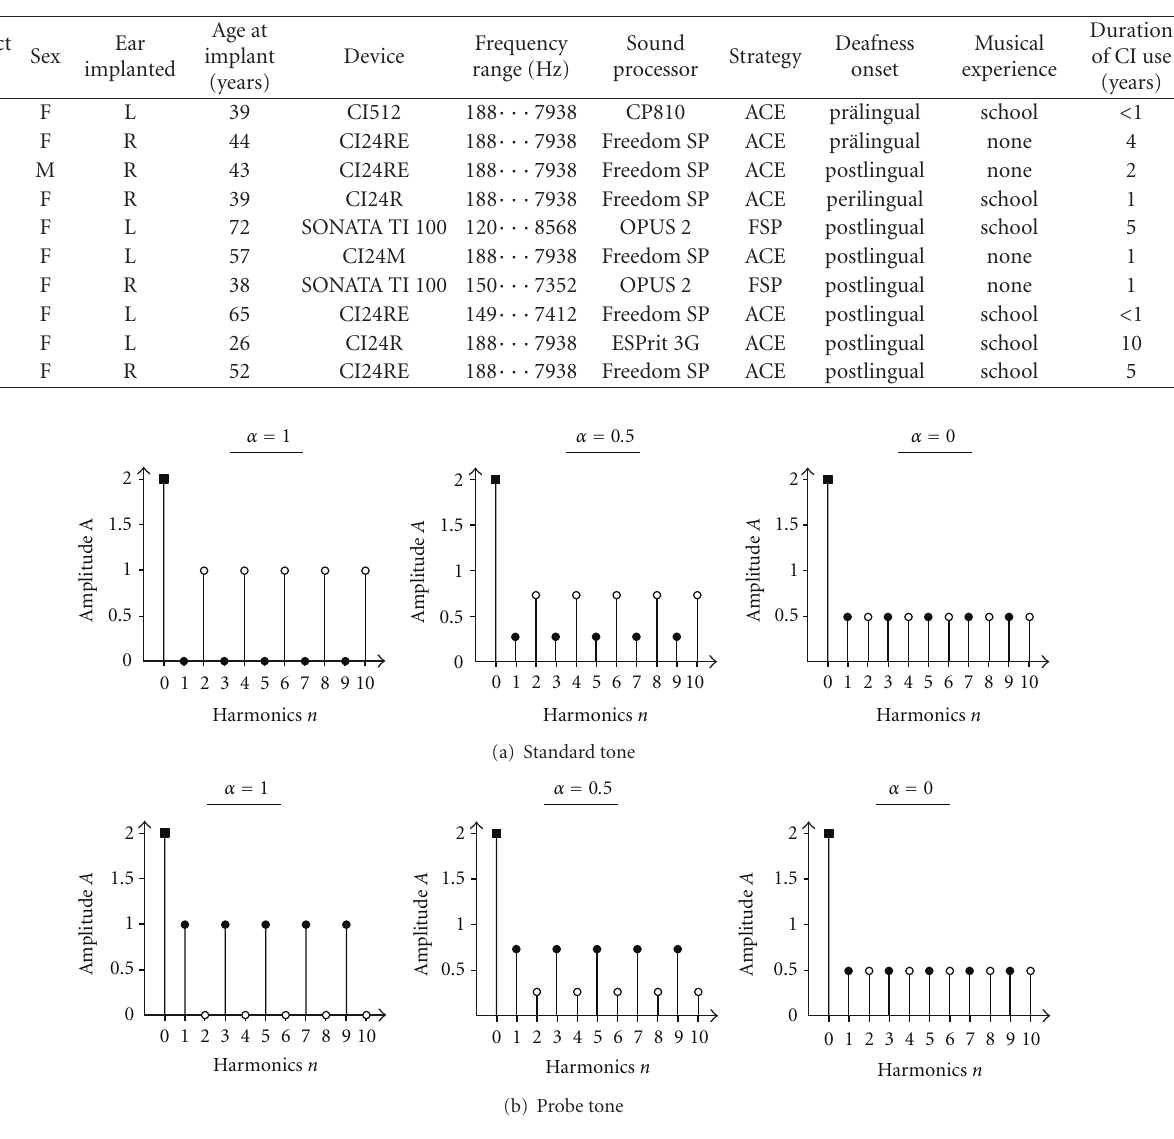
Figure 1: Amplitude spectrums of the standard (upper row) and probe stimuli waveforms (lower row). The amplitude of the fundamental frequency ( n = 0) remains constant, while the amplitudes A of the even (white circles) and odd harmonics (black circles) were cross-faded by the parameter α . Applying no cross-fading ( α = 1), the amplitudes are maximal di ff erent which results in a maximal timbre di ff erence. The amplitudes of all harmonics are equal at maximal cross-fading ( α = 0) which results in stimuli with no timbre di ff